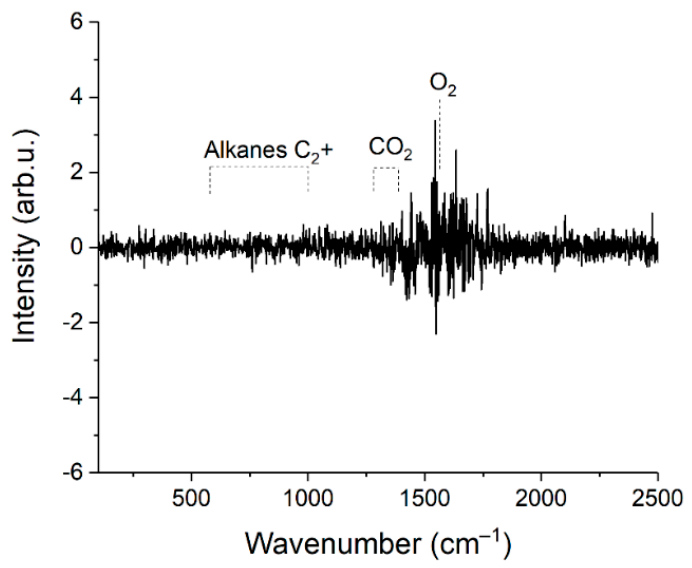
Figure 6. Contributions of the species to the spectrum of sample 1.